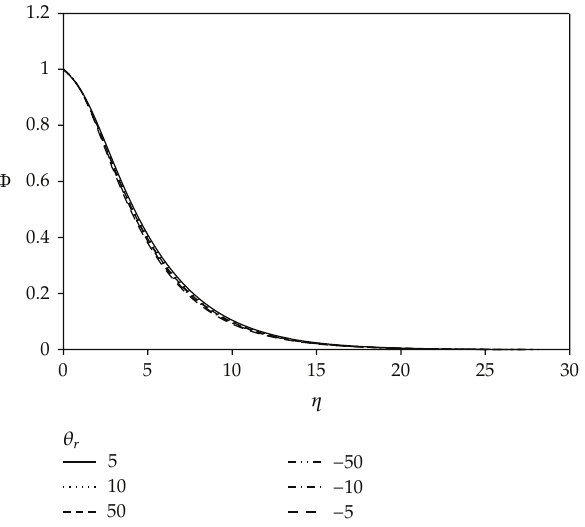
Figure 6: Concentration profile for di ff erent values of θ r for Du (cid:8) 0 . 03, Sr (cid:8) 2, N (cid:8) 1, Le (cid:8) 0 . 1, Pr (cid:8) 0 . 71, and Sc (cid:8) 0 . 1.